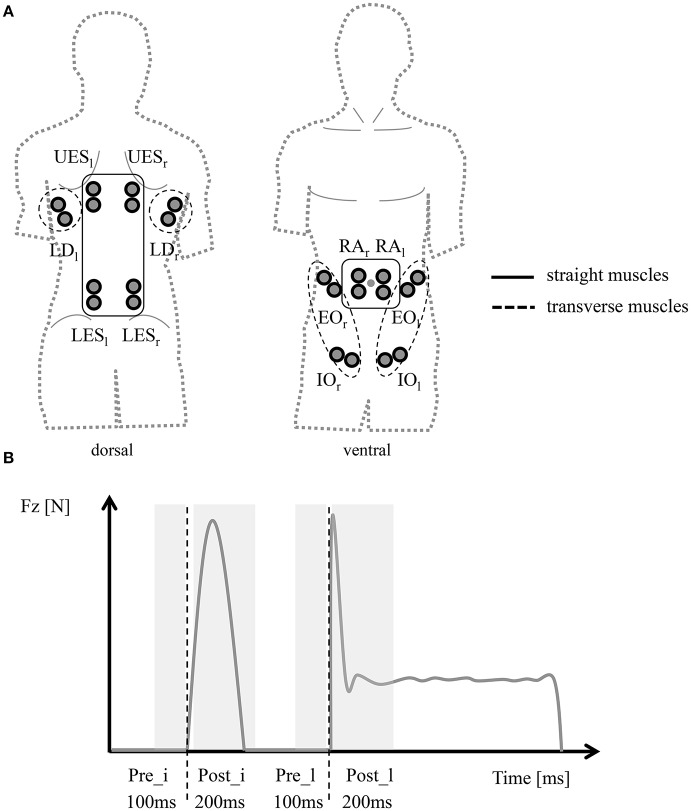
Methodological SEMG setup. (A) Bilateral 12-lead SEMG setup framing groups of transverse and straight trunk muscles. (B) Time windows for SEMG-RMS analysis [100 ms pre- (Pre_i), 200 ms post- (Post_i) initial ground contact; 100 ms pre- (Pre_l), 200 ms post- (Post_l) drop jump landing] triggered by ground reaction force (Fz) signal.